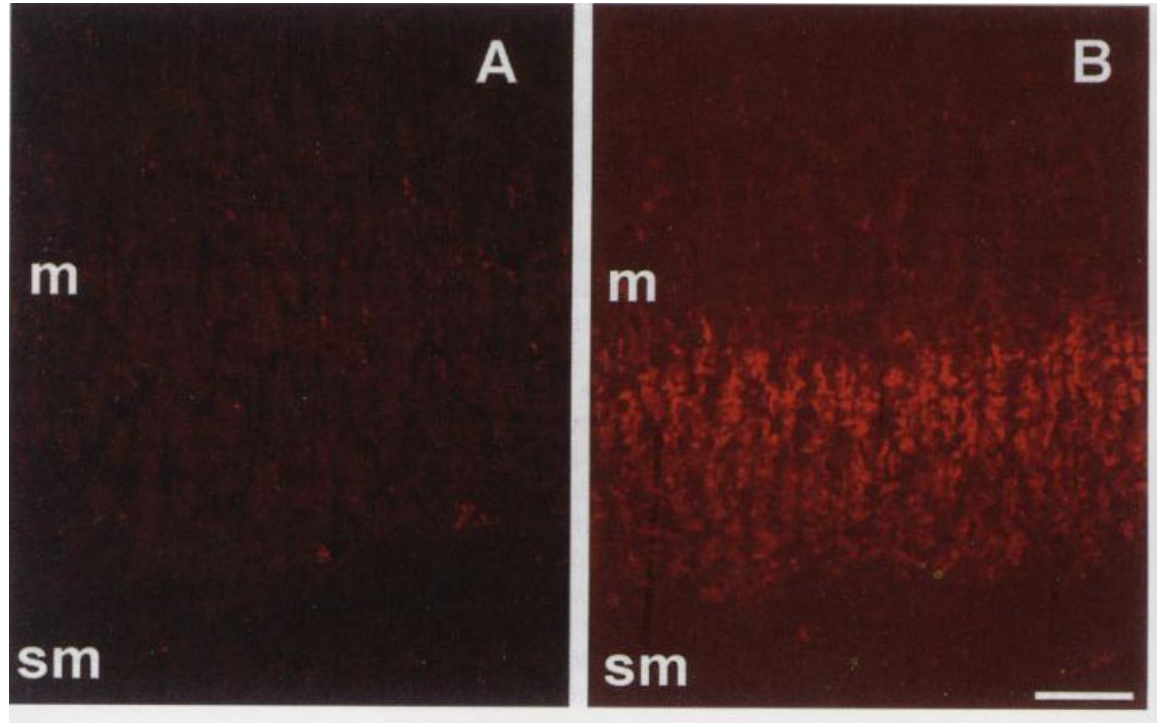
FIGURE 1. Expression of COX-2 in the rat stomach. Panel A shows COX-2 immunostaining in the normal stomach, while panel B shows the marked induction of COX-2 1 h after oral administration of aspirin (250 mg/kg). m, mucosa; sm, submucosa. The bar at the bottom of panel B represents 15 μ m. Further details of these experiments can be found in Davies et al.[19].